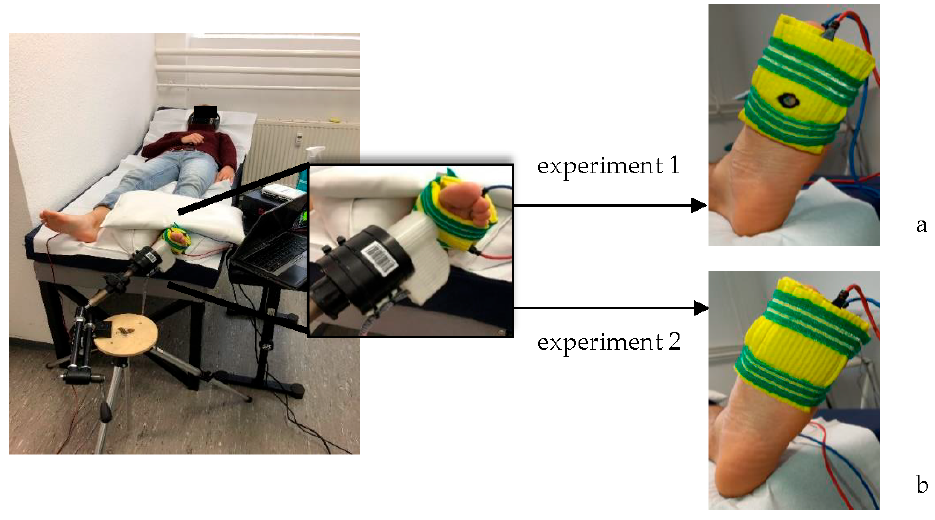
Figure 1. Setup of the VPT measurement with the applied plate electrodes for parallel subliminal electrical noise stimulation for experiment 1 ( a ) and experiment 2 ( b ).